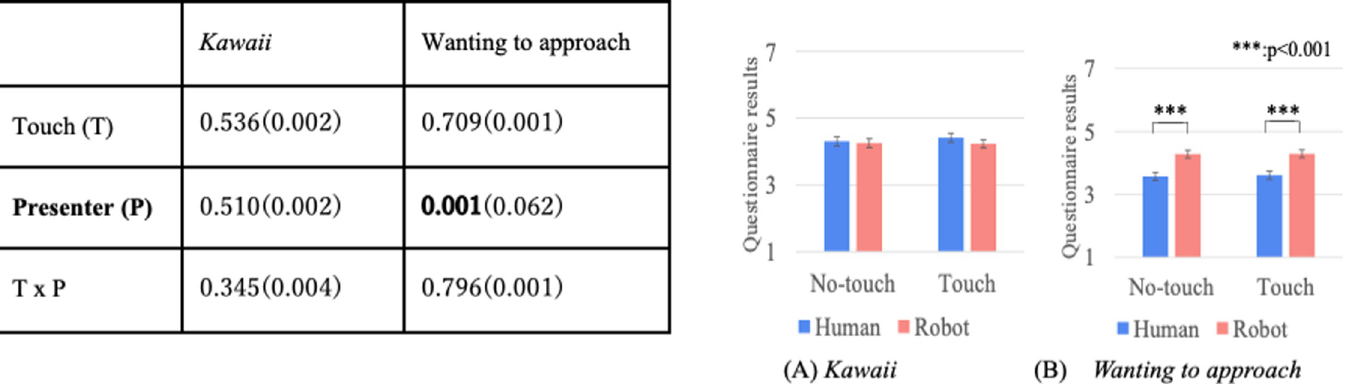
Fig 11. Participants’ feelings of kawaii and wanting to approach